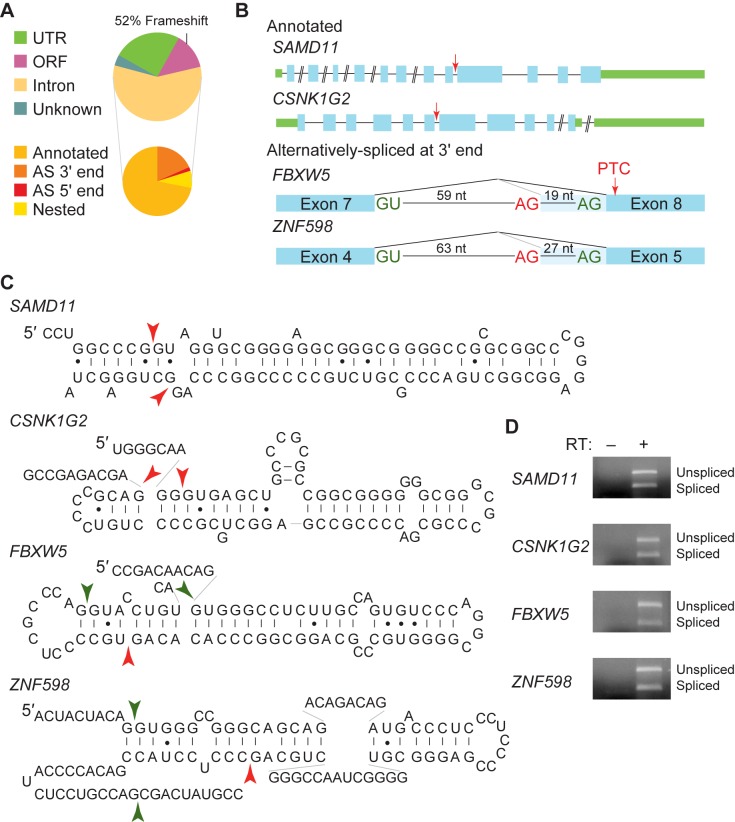
Canonical short introns may be produced by unconventional splicing.(A) Of the 600 short introns with the greatest sequencing read support, canonical introns were examined for their positions within mRNAs. The majority were known introns, with annotated 5ˈ and 3ˈ splice sites (Annotated), but a smaller number were unannotated, using a known splice site and an unannotated 3ˈ (AS 3ˈ end) or 5ˈ (AS 5ˈ end) splice site for intron excision. For short introns in ORFs, 52% of these are predicted to change the mRNA reading frame. (B) A small subset of short introns is examined more closely. Shown are the SAMD11, CSNK1G2, FBXW5, and ZNF598 loci. The SAMD11 and CSNK1G2 loci both encode pre-mRNAs harboring annotated short introns. Note that both loci encode pre-mRNAs with clusters of short introns (with the shortest intron indicated by a red arrow). The FBXW5 and ZNF598 loci both encode pre-mRNAs that are likely alternatively spliced to yield a short intron. In both cases, the flanking exons and intron are shown. For the FBXW5 mRNA, it is predicted that short intron splicing would change the reading frame of the protein product resulting in a premature termination codon (PTC). (C) For SAMD11, CSNK1G2, FBXW5, and ZNF598 pre-mRNAs, the short intron with ten nucleotides from each flanking exon was folded computationally. Note that each intron folds into extensive secondary structure with intron ends positioned in proximity. Intron ends are indicated with arrowheads, and for FBXW5 and ZNF598 pre-mRNAs, both the annotated splice sites (green) and alternate splice sites (red) are indicated. (D) We used RT-PCR to confirm short intron removal in the SAMD11, CSNK1G2, FBXW5, and ZNF598 pre-mRNAs. For the FBXW5 and ZNF598 pre-mRNAs, primers were designed to specifically detect short intron splicing (one primer sequence within the alternatively spliced region); for the other pre-mRNAs, primers were located outside the short intron to detect both pre-mRNA and spliced mRNA. As predicted from our splicing efficiency analysis, every short intron was alternatively spliced. Samples that omitted reverse transcriptase (from the RT step) serve as a control for contaminating DNA.